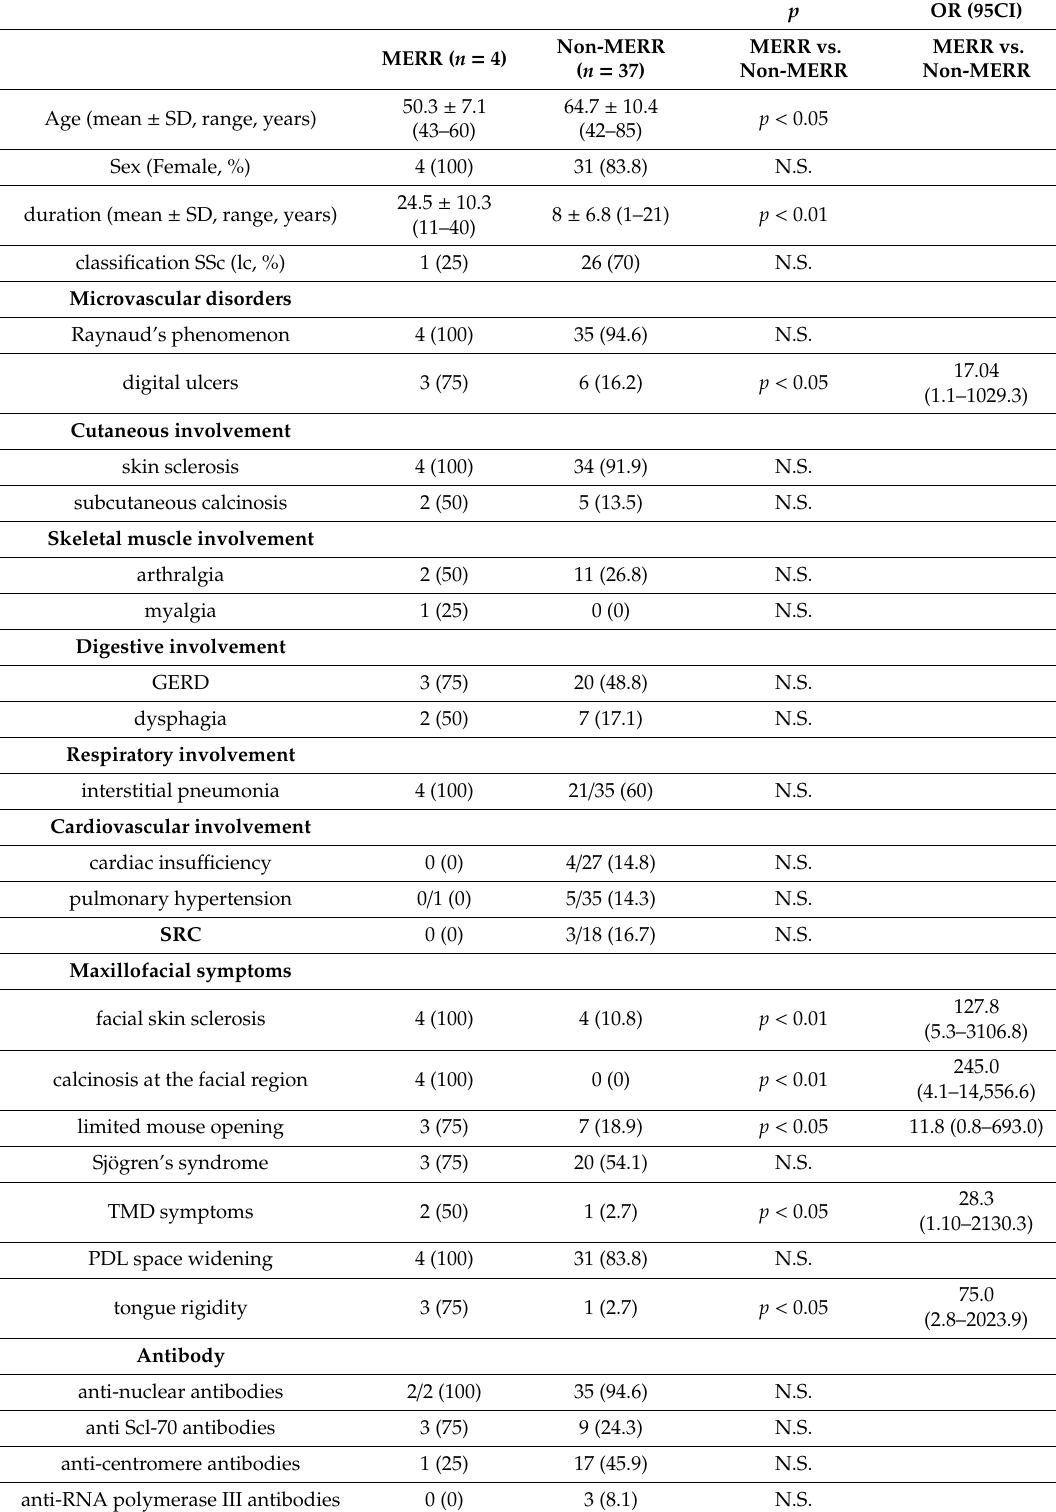
Table 3. Systemic and maxillofacial manifestations in multiple external root resorption (MERR) and non-MERR patients. Systemic and maxillofacial involvement and antibodies; number (%). When the total number was less than 41, it was described as number / total number. OR; Odds ratio, CI; confidence